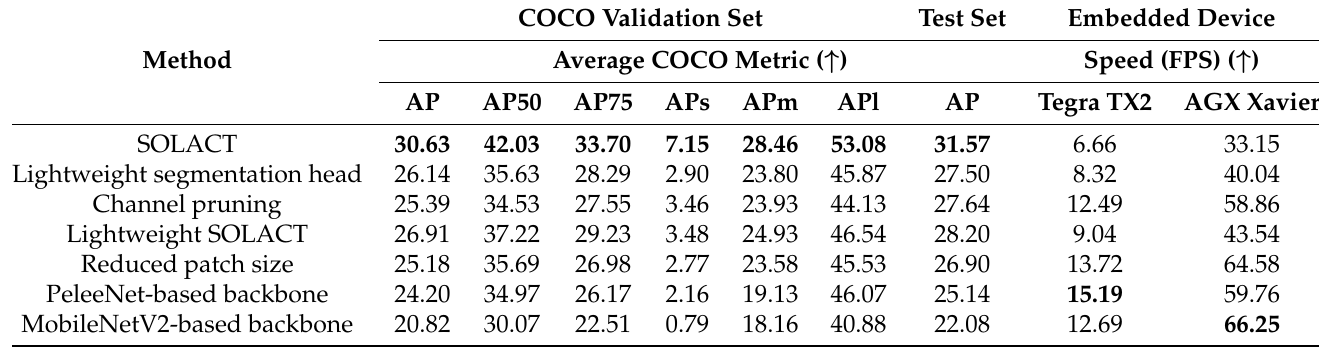
Table 3. Study of the architecture and scheme variations of SOLACT.